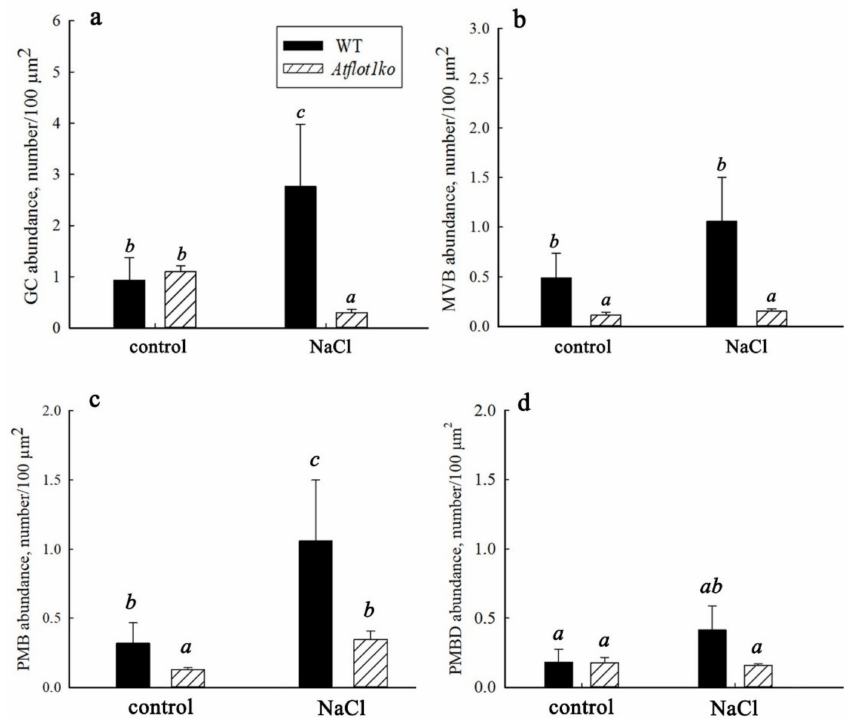
Figure 7. The frequency of occurrence of GCs ( a ), MVBs ( b ), PMBs ( c ), and PMBDs ( d ) in the root cells of 4-day seedlings of A. thaliana WT and Atflot1ko plants grown either in the absence or in the presence of NaCl. Means ± SE using 100 individual cells are given ( n = 100). Different letters indicate statistically significant differences (ANOVA; p <